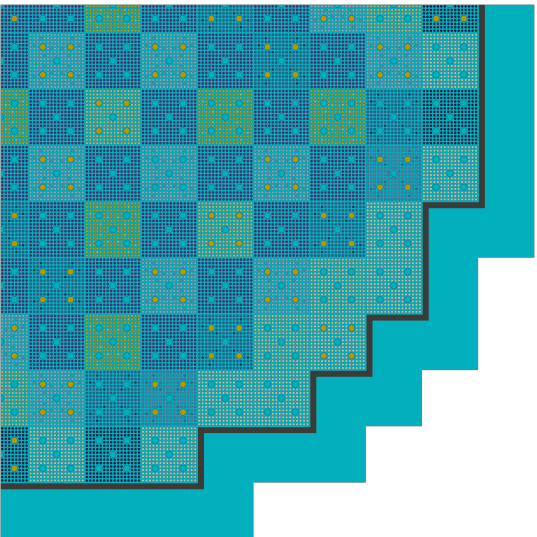
Figure 7. 2-D Core Model in